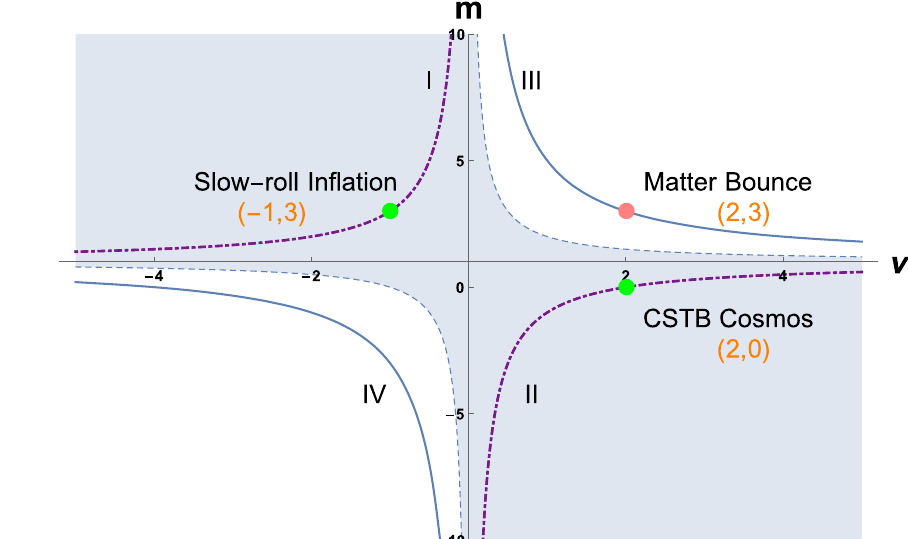
Fig. 1 The shaded region includes all time-independent solutions satisfying ( m − 1 )ν − 1 < 0 whose boundaries are defined by ( m − 1 )ν − 1 = 0 delineated by thin dash lines. The purple dot-dash lines obeying ( m − 1 )ν = − 2 represent scale-invariant as well as time-independent solutions. Another set of scale invariant solutions given by ( m − 1 )ν = 4 (violet solid lines) have Fourier modes varying with time and